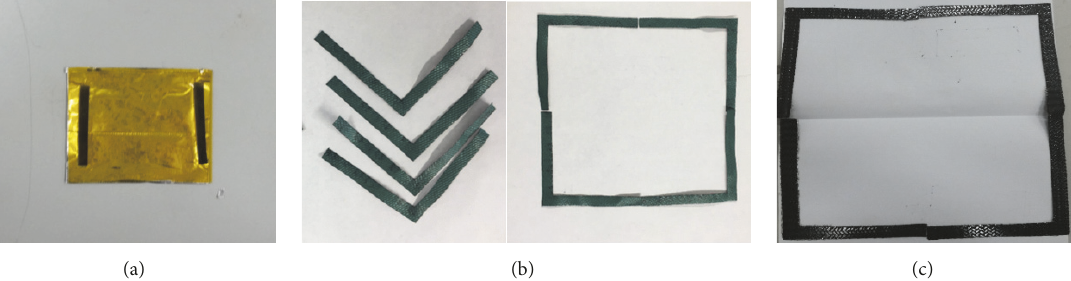
Figure 2: From (a) to (c) SMA foils applied on the solar sail surface, the composite prepregs, and the composite loom.